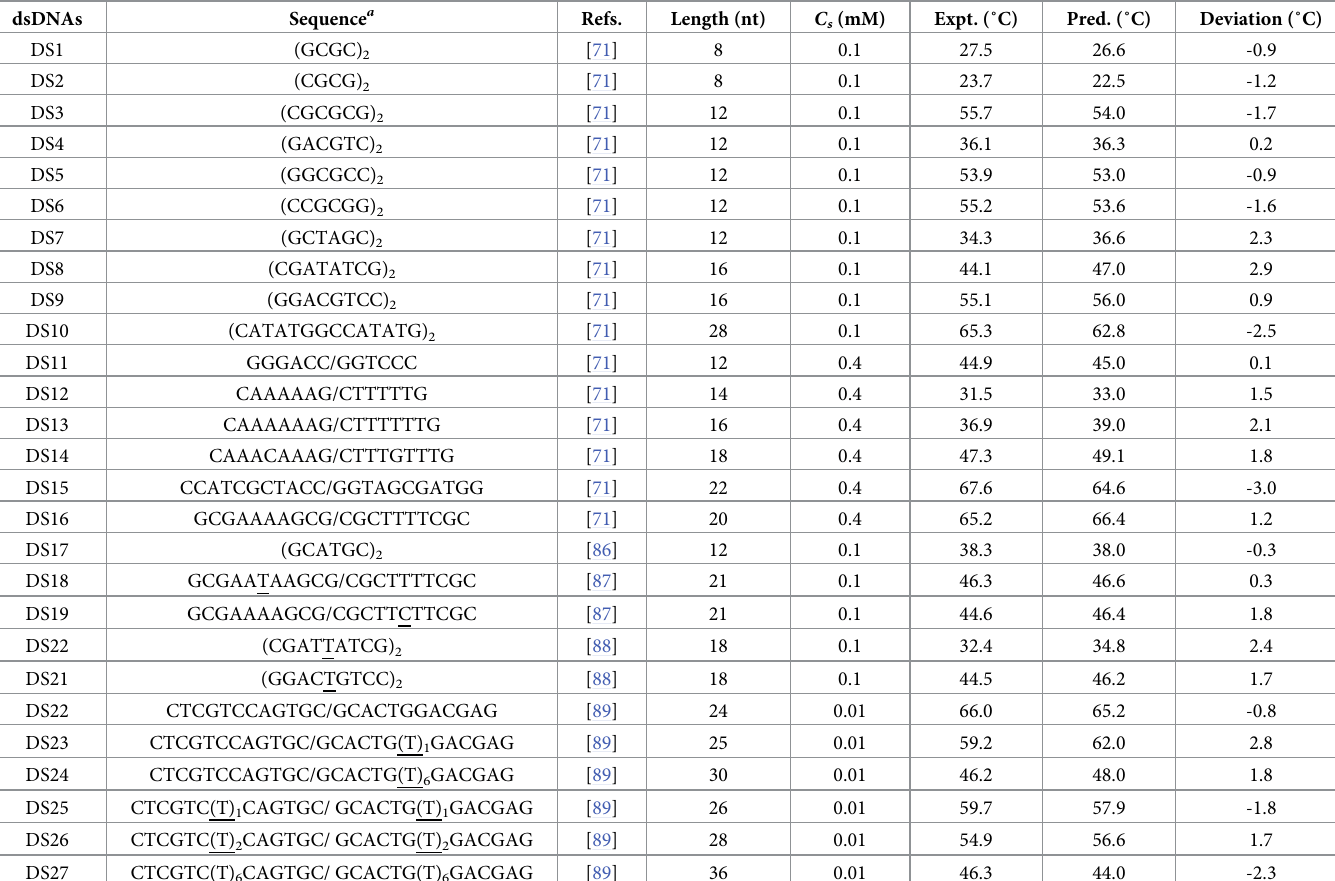
Table 1. The melting temperatures ( T m ) for dsDNAs at 1M [Na + ].